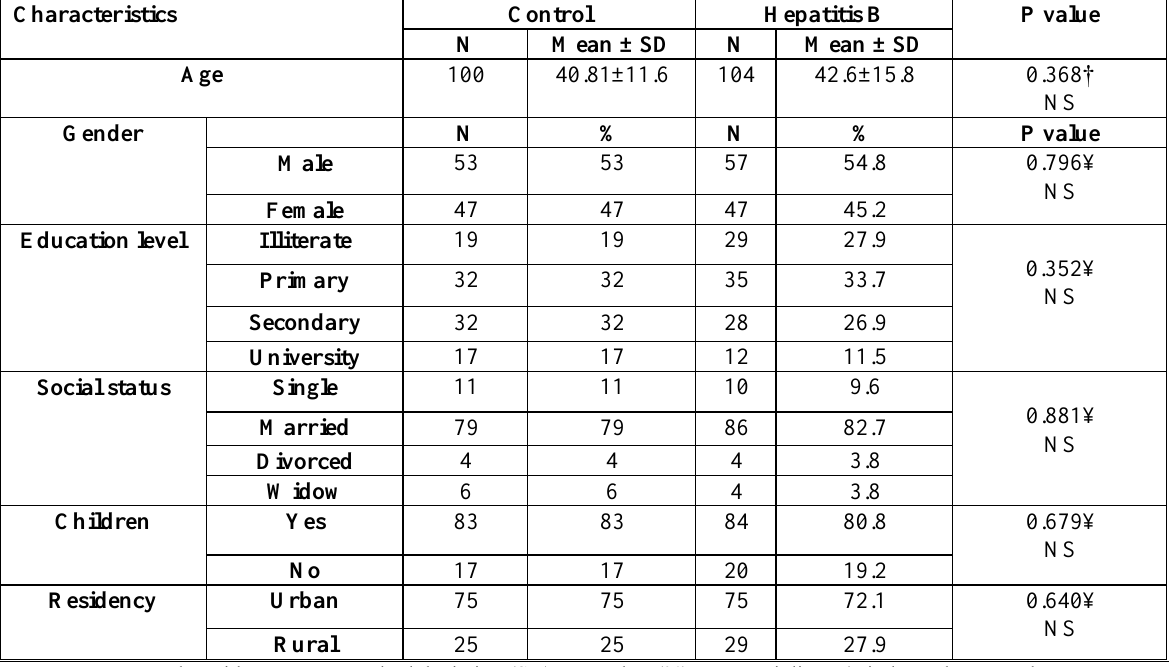
Table 1. Demographic characteristics of patients with chronic hepatitis B infection compared to that of control group.